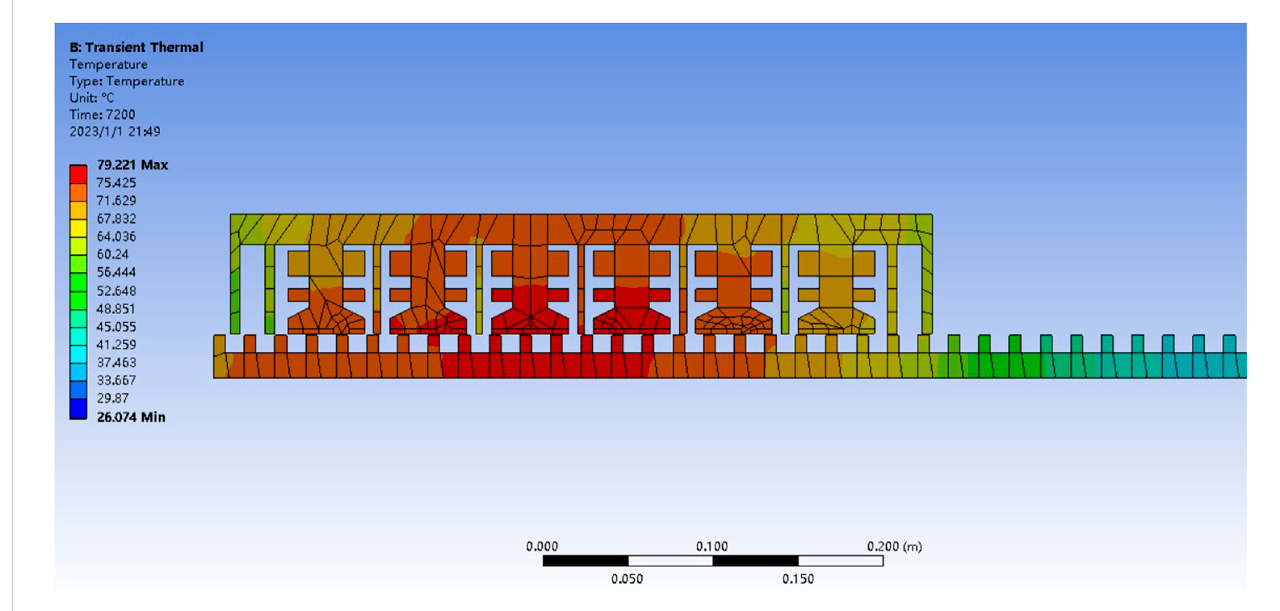
FIGURE 13 The temperature of sectional drawing of the motor.